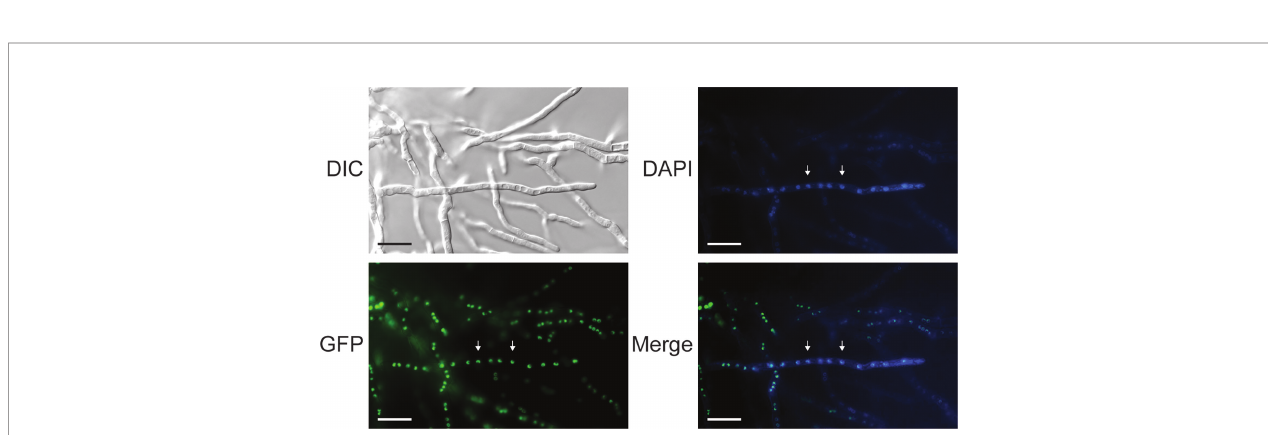
FIGURE 4 | Differential interference contrast (DIC) and fl uorescence microscopy to localize EGFP-Tom1 in subcellular structures. P2niaD18::EGFP-Tom1 transformants show nuclear localization of EGFP-Tom1 in mycelial cells. Arrowheads point to nuclei, which were identi fi ed by staining with 4 ′ ,6-diamidino-2- phenylindole (DAPI). Merge: merged images of DAPI and GFP fl uorescence. Scale bars, 20 m m.